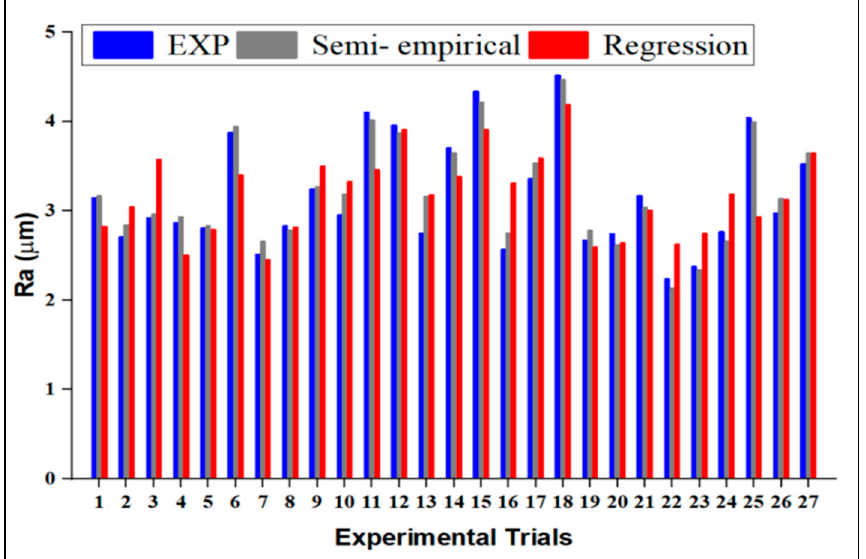
Figure 6. Comparison between experimental, semi-empirical and regression methods.